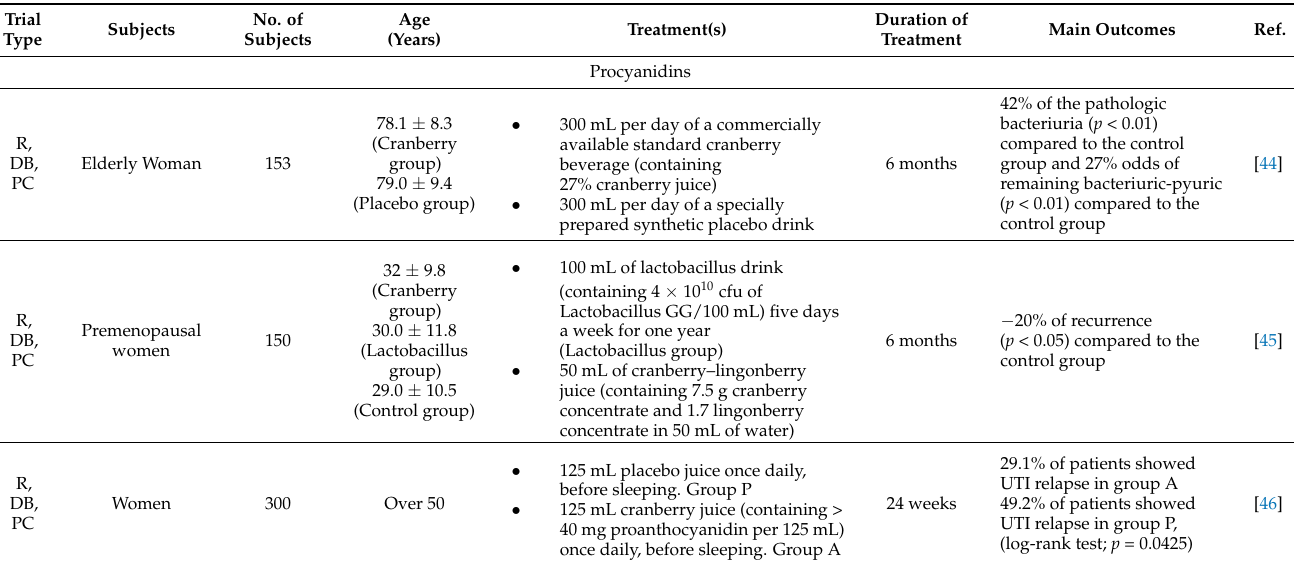
Table 1. Most-relevant published clinical trials from the last 15 years reporting effects on UTI treatment after supplementation with food-derived